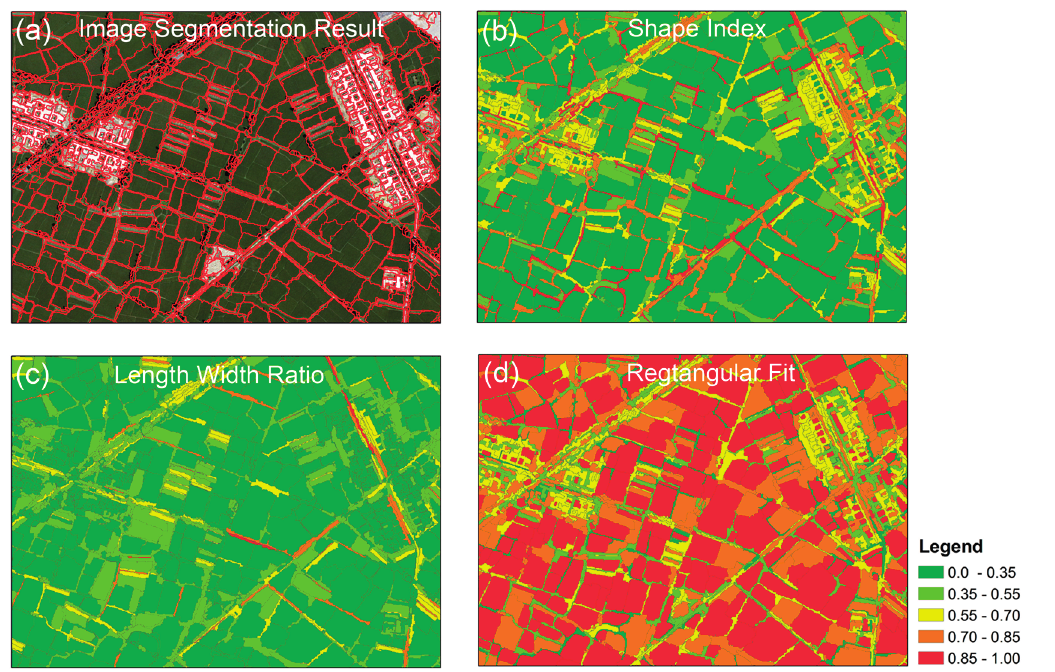
Figure 9. Image geometric features: ( a ) the segmentation result of the remote sensing imagery; ( b ) the shape index feature; ( c ) the length/width ratio; and ( d ) the rectangular fit